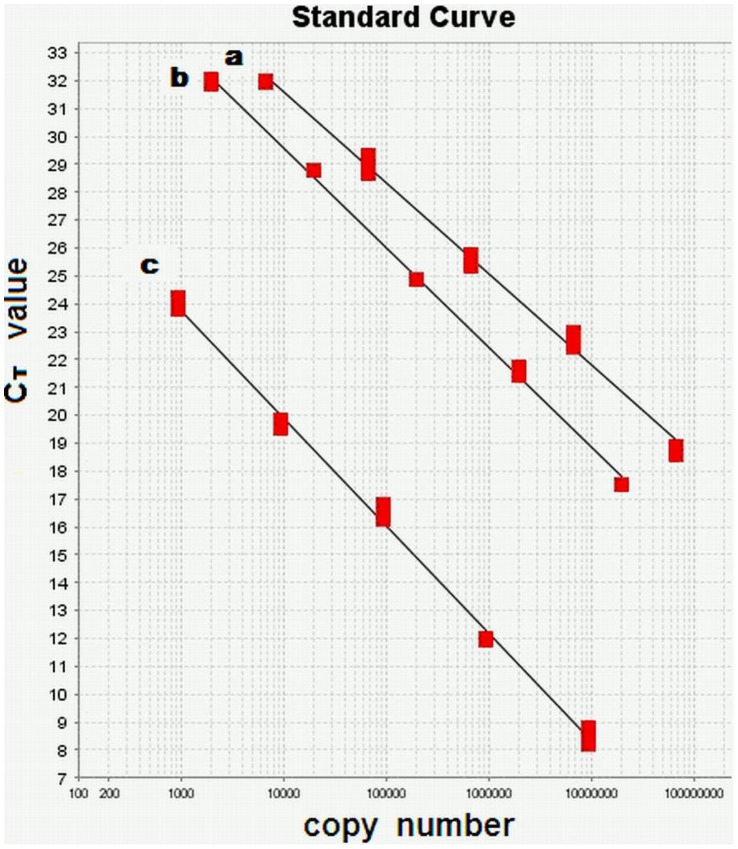
Standard curves for quantification of mtDNA.Copy number standards in 10-fold dilutions were used for qPCR, and the ranges of copy number used in this experiment were 6.77×107∼6.77×103 copies/µl for A3243G mutant mtDNA, 1.97×107∼1.97×103 copies/µl for wild-type mtDNA, and 9.53×106∼9.53×102 copies/µl for β-hemoglobin gene. (a) Standard curve for A3243G mutant mtDNA, slope = −3.257, r2 = 0.994; (b) standard curve for wild-type mtDNA, slope = −3.576, r2 = 0.998; (c) standard curve for β-hemoglobin gene, slope = −3.854, r2 = 0.996. Experiments were done in triplicate.